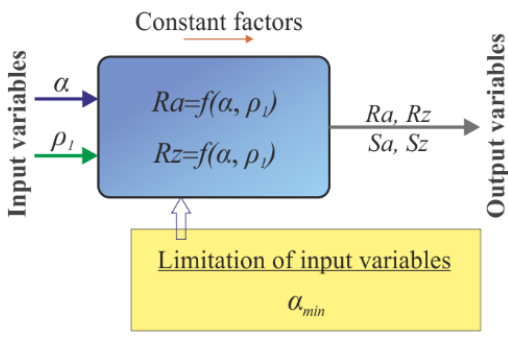
Figure 5. Structure of the research object.